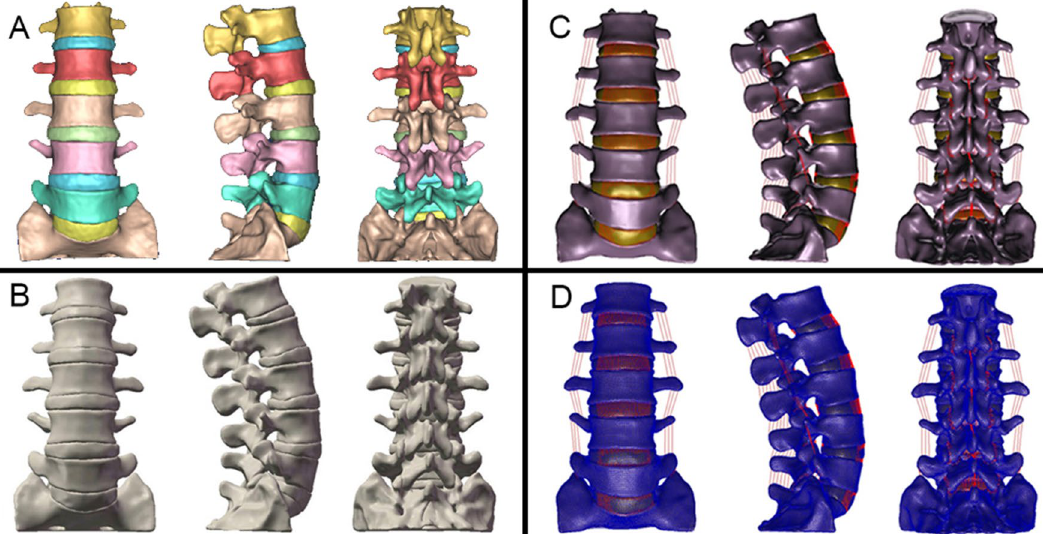
Figure 2. The procedure to establish the intact FE model of L1–S1 vertebrae. ( A ) a rough 3D model of L1–S1 vertebrae, ( B ) the rational non-uniform geometry structure of the model, ( C and D ) setting of the nonlinear simulation of ligaments and the meshing of the